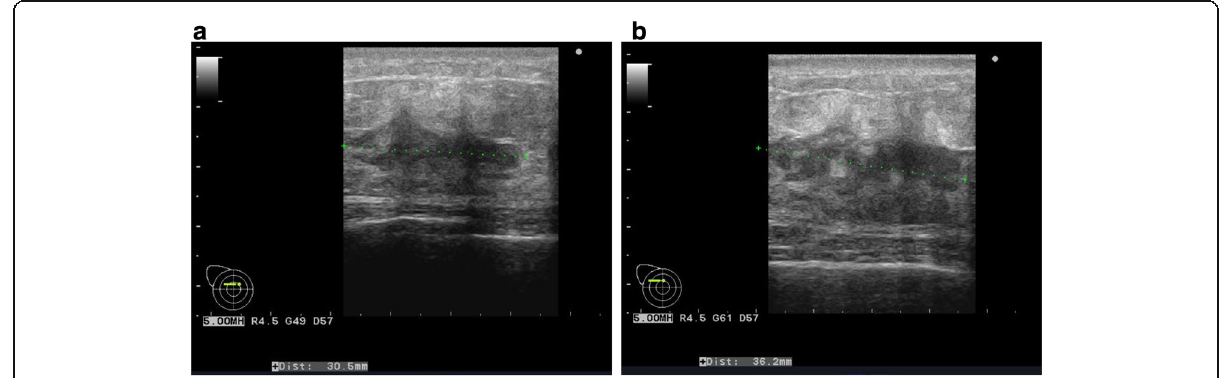
Fig. 1 a Ultrasonographic images of the patient with the tumor. The inside of the tumor had a low echoic area, and the tumor borders were unclear. b The tumor grew larger 2 months later